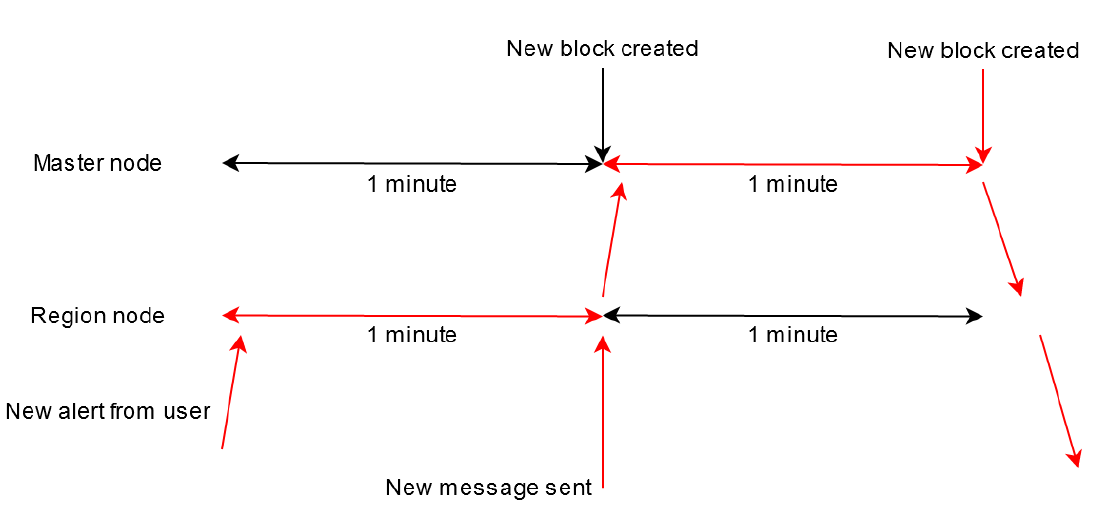
Figure 16. Propagation time - worst-case